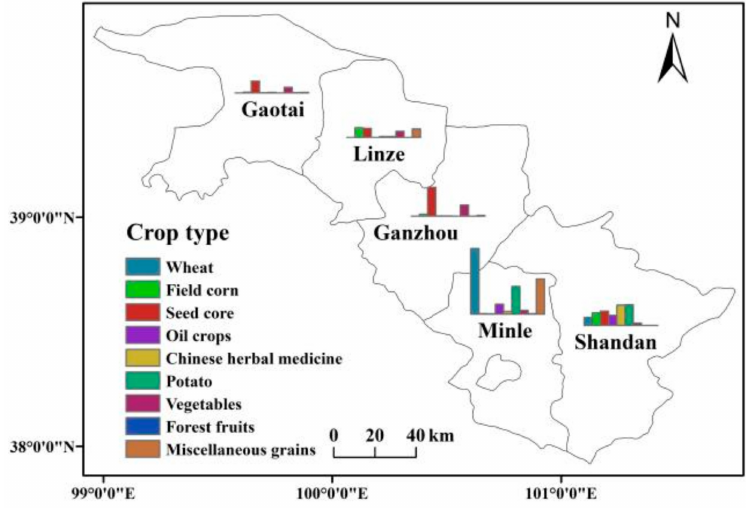
Figure 7. Spatial distribution of planting types of scale management